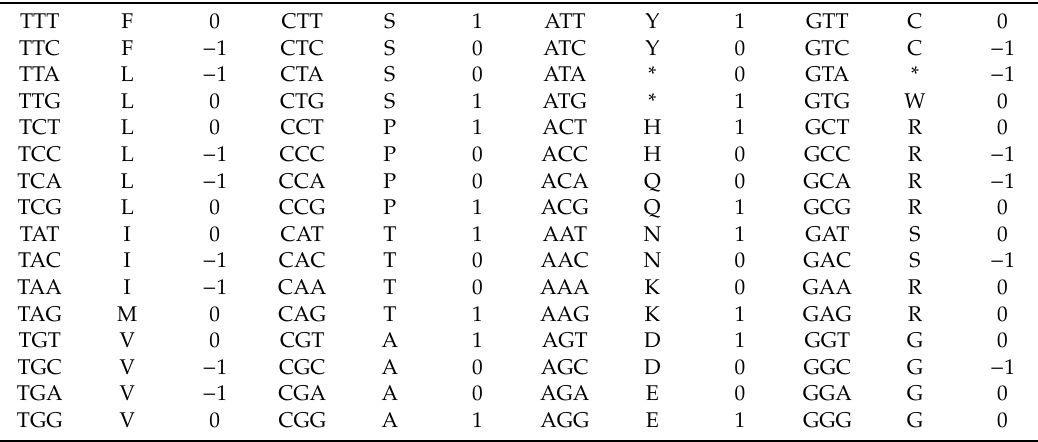
Table 2. The tautomeric codon directional asymmetry (CDA) of the genetic code’s 64 codons as defined by the keto-enol / amino-imino divide, for N2N1N3 swapped codons. Side dominance is defined by occupancy of nucleotides with keto and enol tautomeric isoforms, G and T (* for